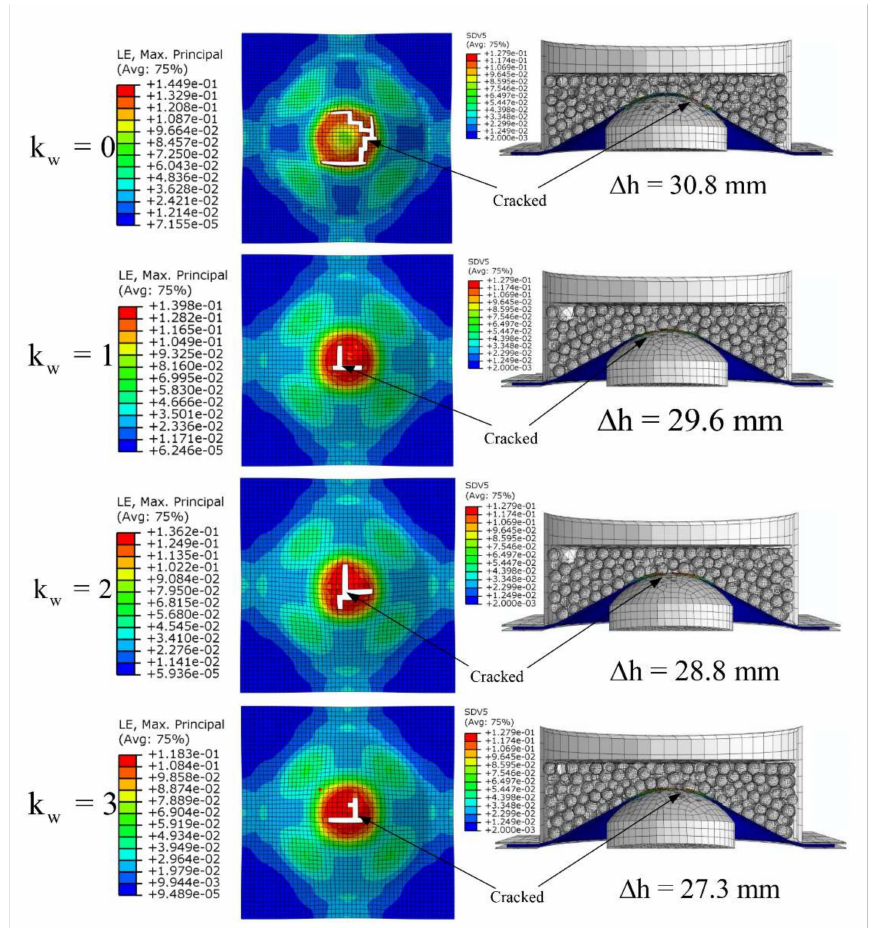
Figure 11. Logarithmic strain and damage distribution under different damage parameter k w . (SDV5 represented void volume